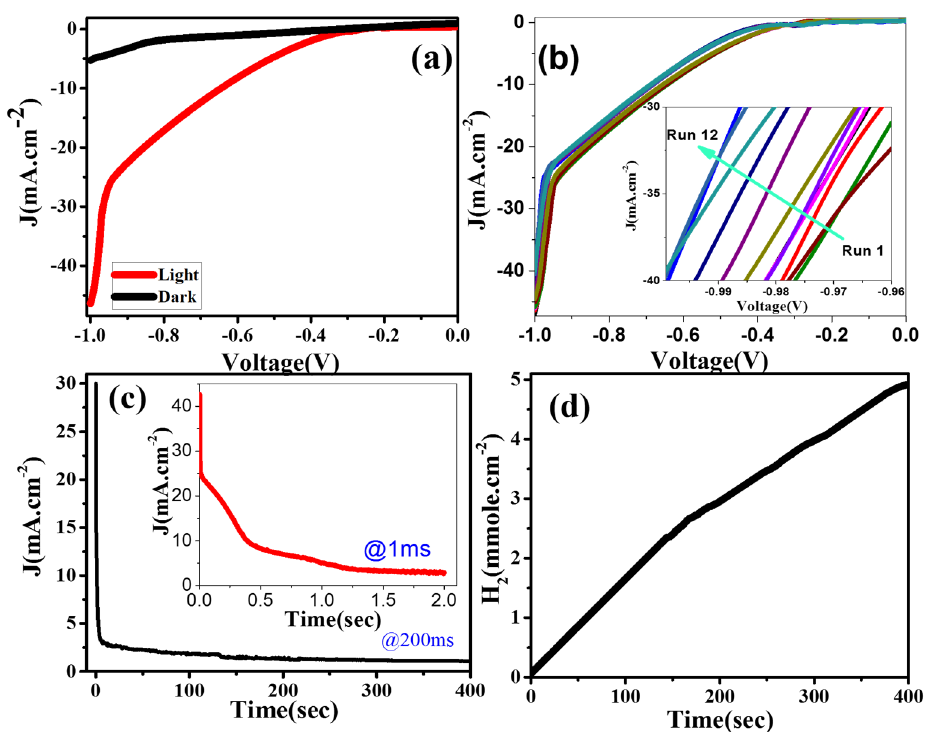
Figure 6. The dependence of J ph on the applied voltage of the 3.0% Ni-doped SnO 2 :Ir photoelectrode ( a ) in the dark and under white light and ( b ) for 12 runs of reusability under white light illumination at room temperature; ( c ) J ph versus exposure time and ( d ) the number of H 2 moles at time of generation for the 3.0% Ni-doped SnO 2 :Ir photocathode at − 1V and room temperature. The insets of ( b ) and ( c ) showed magnified parts of the curves.